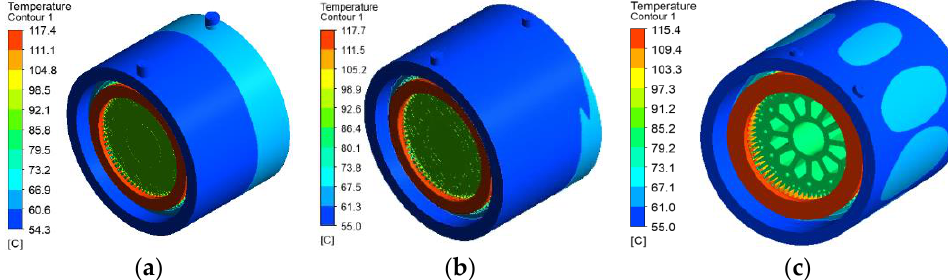
Figure 6. Machine temperature distributions. ( a ) Axial spiral type. ( b ) Axial S type. ( c ) Circumferential S type.